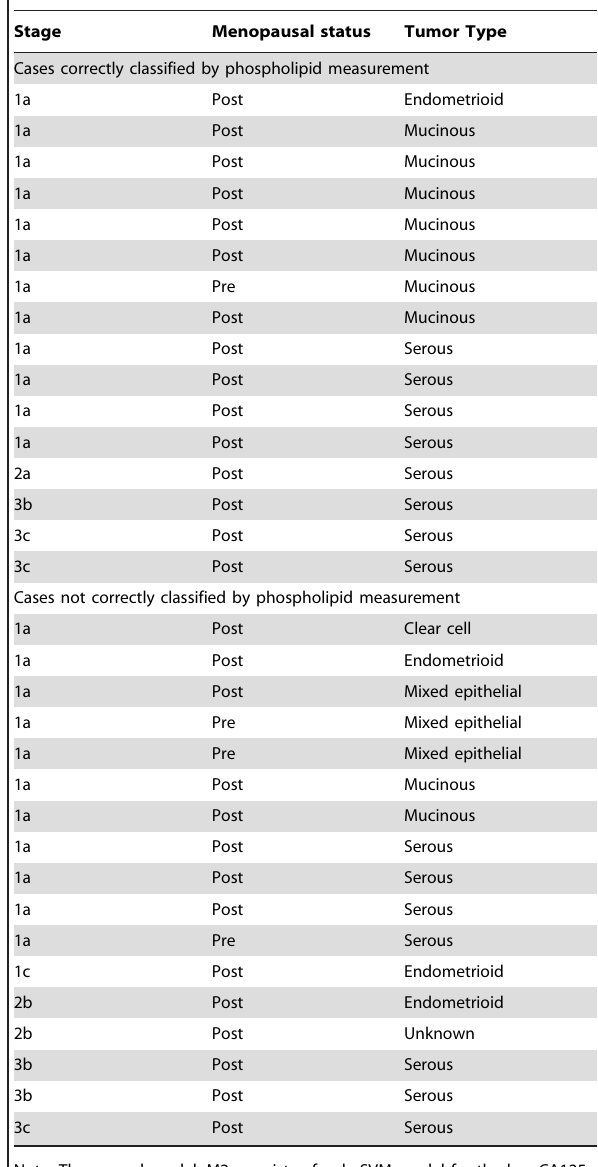
Table 6. Characteristics of cases missed by CA125 using a cutpoint of 35 units/ml and correctly identified/not identified by model 2 (M2) using phospholipid